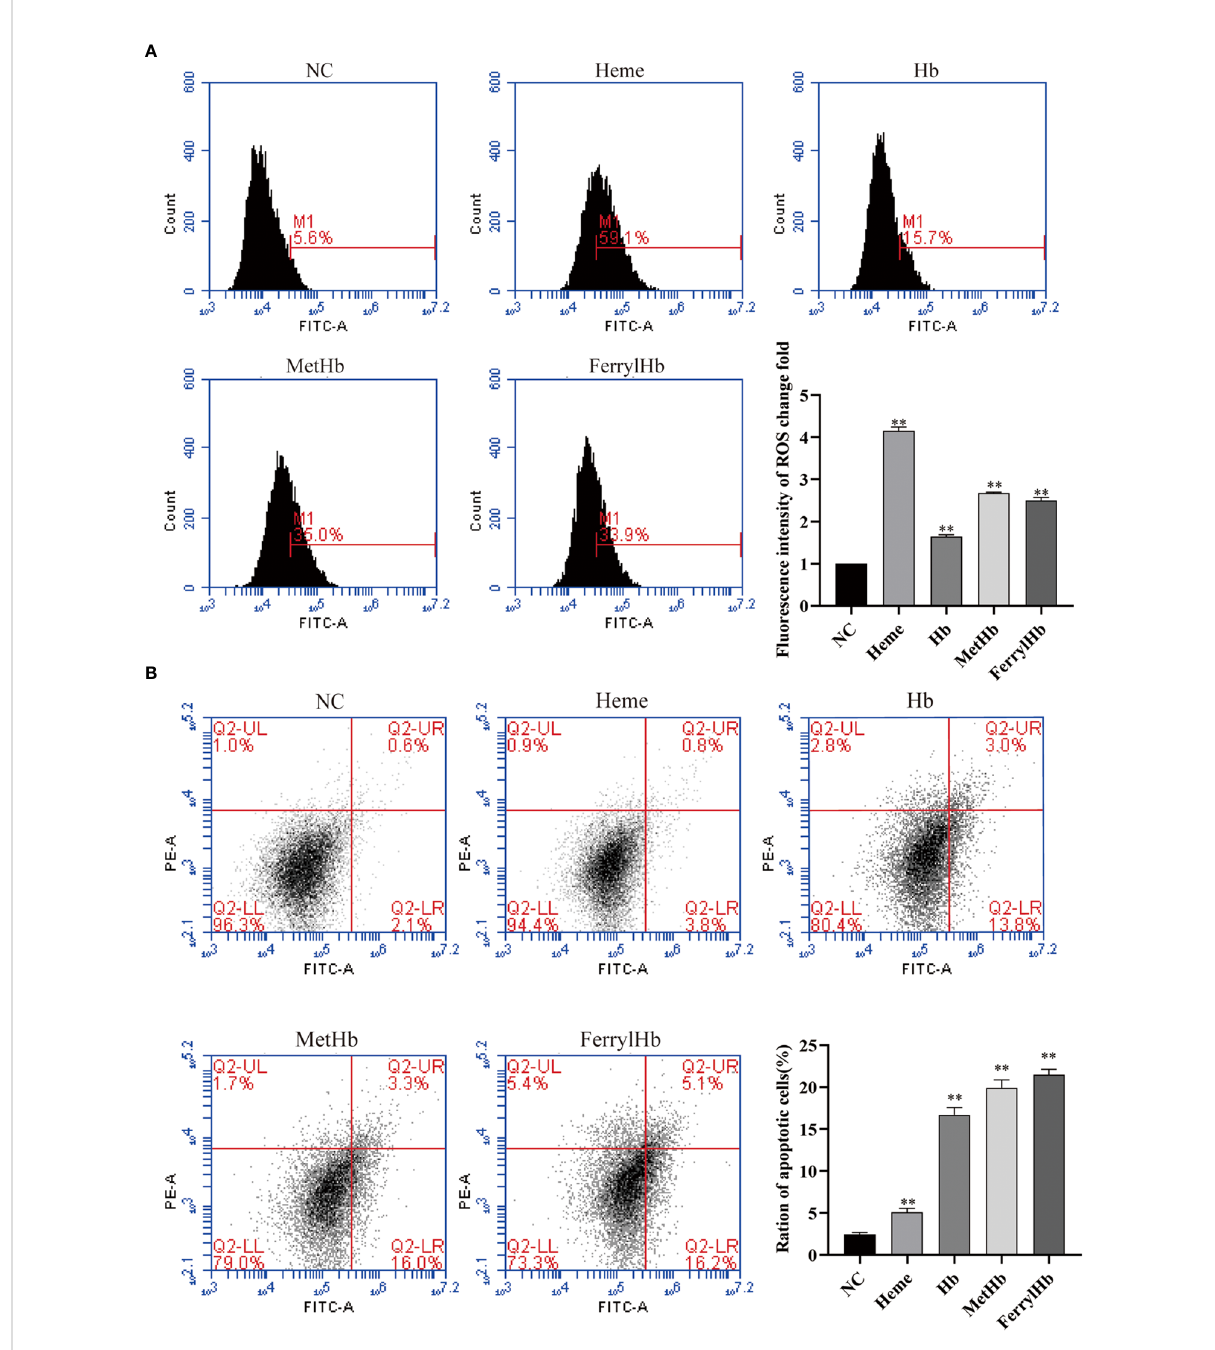
FIGURE 6 Different valence of Hb increased the production of ROS and apoptosis of L8824 cells. (A) Detection of ROS content of heme and different Hb infected L8824 cells after 12h by fl ow cytometry using DCFH-DA probe (B) Effect of heme and different Hb on apoptosis after incubation of L8824 cells for 12 h using Annexin V and PI dye. Data are the mean of three independent experiments and are expressed as mean ± SEM (**P <